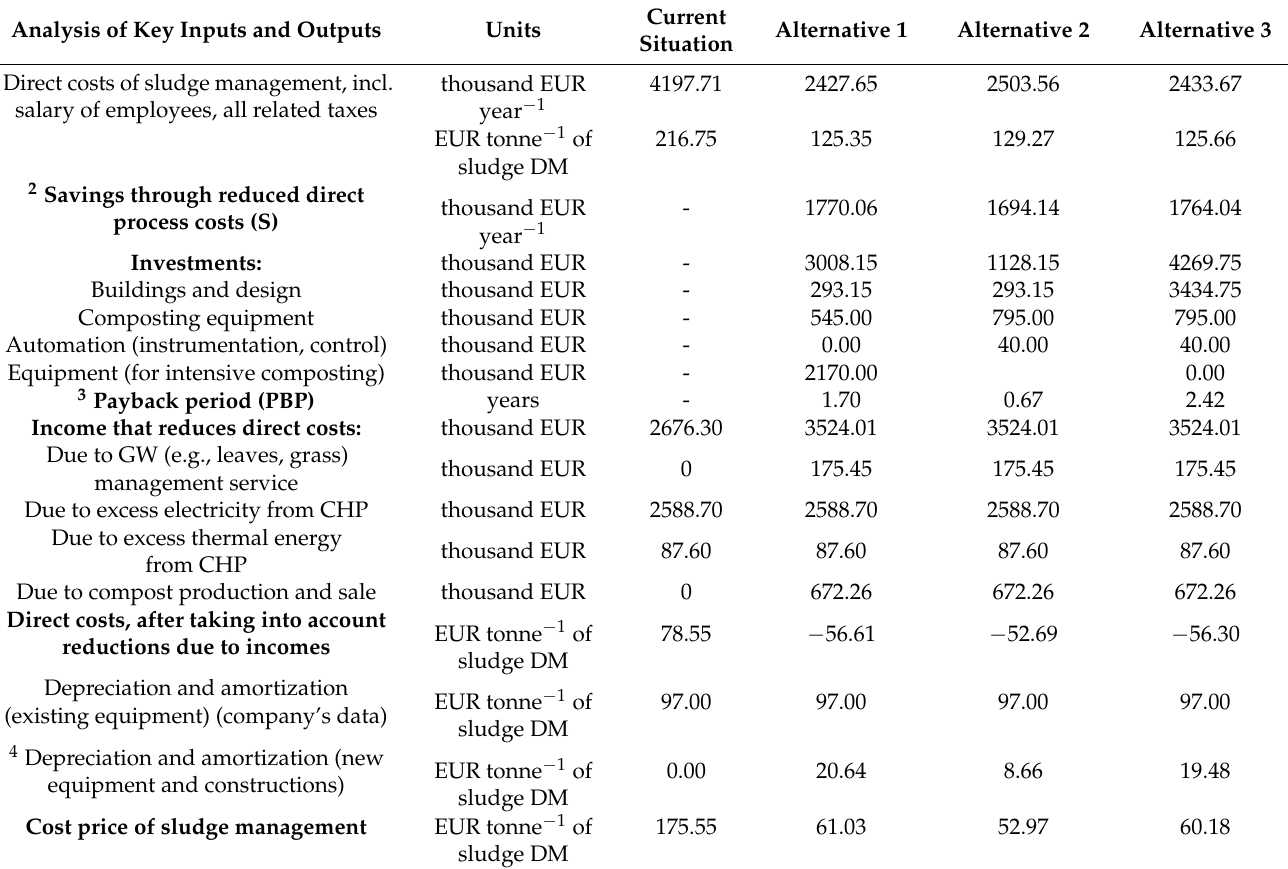
Table 6. Results of the economic evaluation of suggested alternatives for 1 sludge